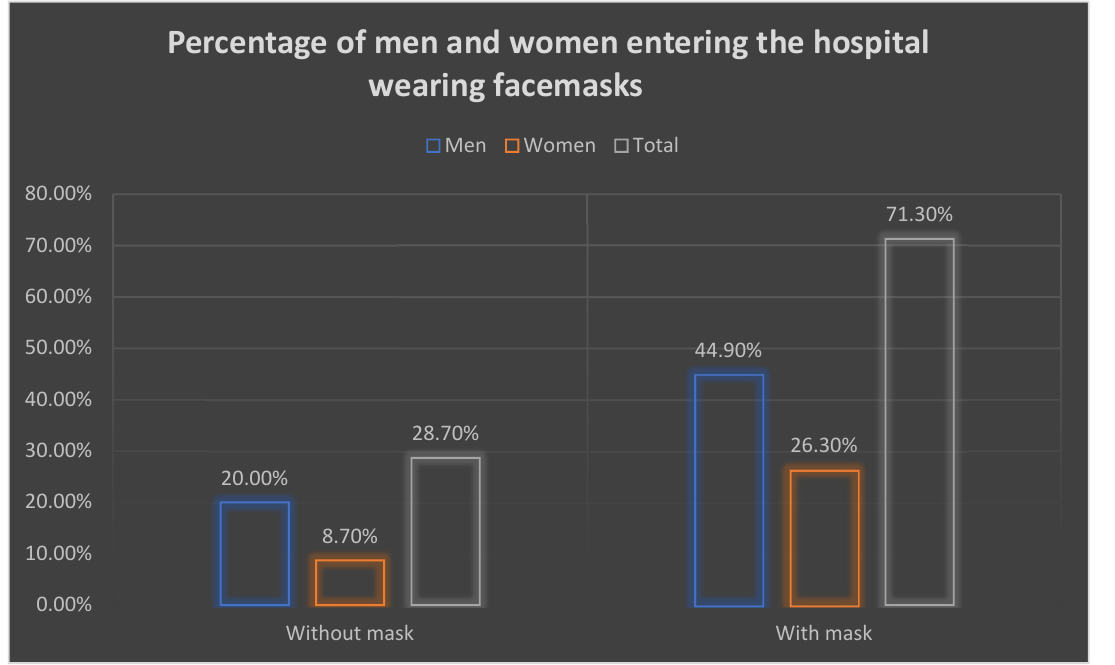
Figure 1. Percentage of men and women entering the hospitals wearing masks.